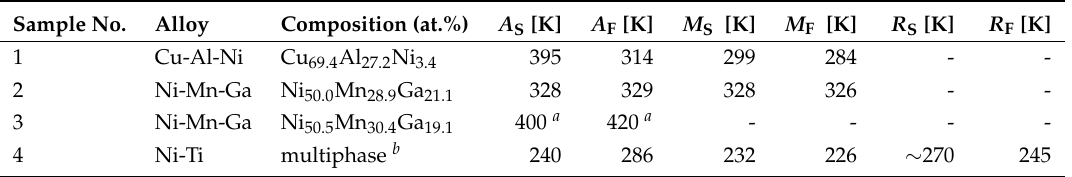
Table 1. Chemical compositions of the studied samples and the corresponding transition temperatures determined by differential scanning calorimetry (if not stated